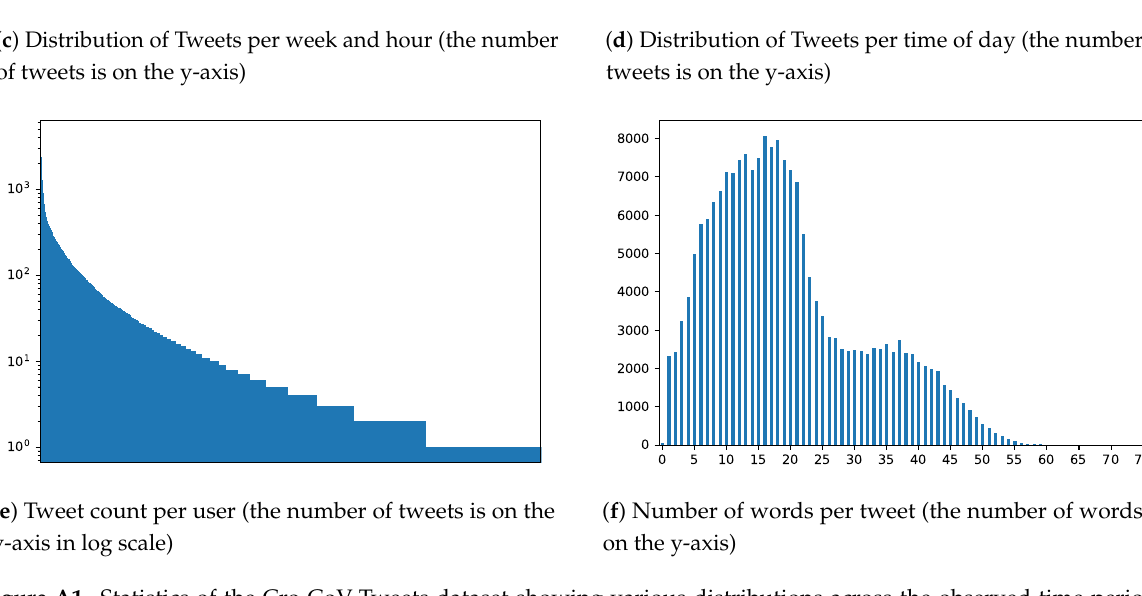
Figure A1. Statistics of the Cro-CoV-Tweets dataset showing various distributions across the observed time period (1 January 2020–31 May 2021): frequencies of tweets per week ( a ), frequencies of tweets per month ( b ), frequencies of tweets per week and hour ( c ), frequencies of tweets across time of the day ( d ), frequencies of tweets per user ( e ), frequencies of words in tweets ( f ).